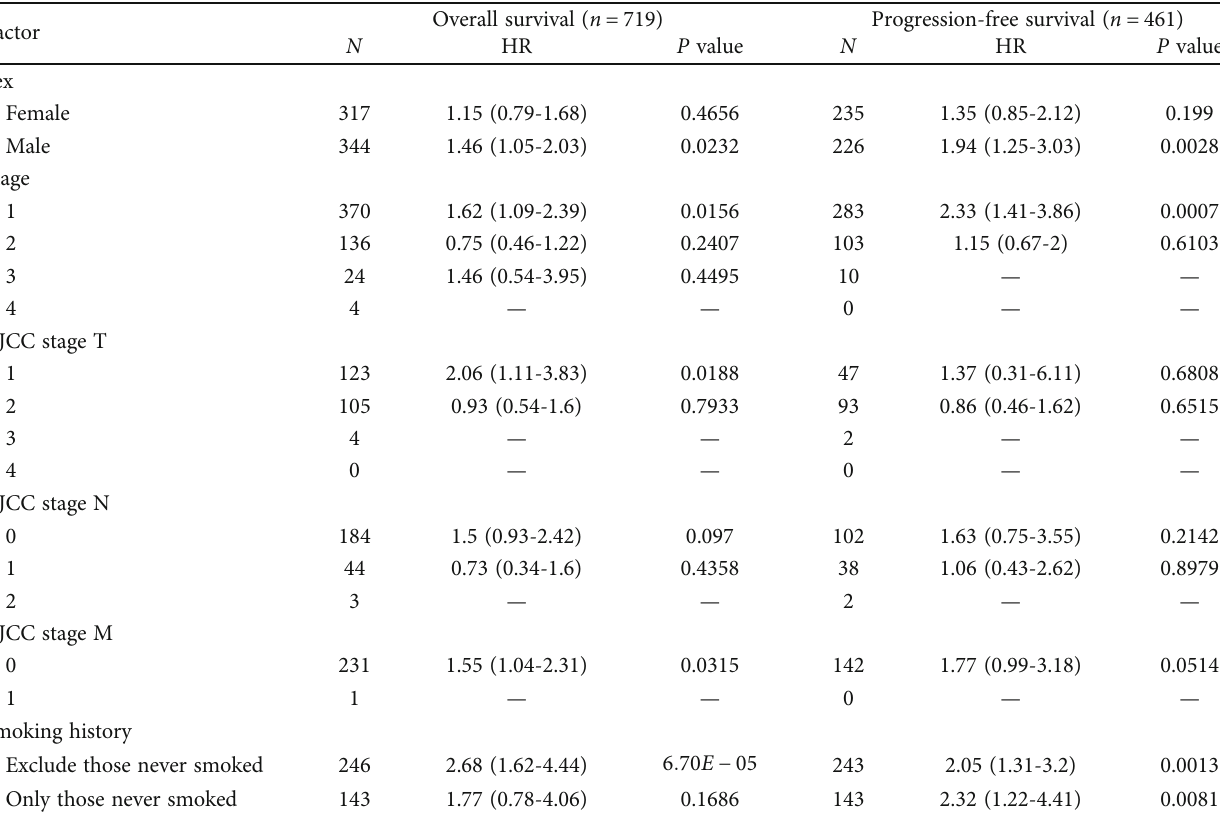
Table 1: Correlation of SLC2A5 mRNA expression and clinical prognosis in LUAD with di ff erent important clinical characteristics by Kaplan-Meier